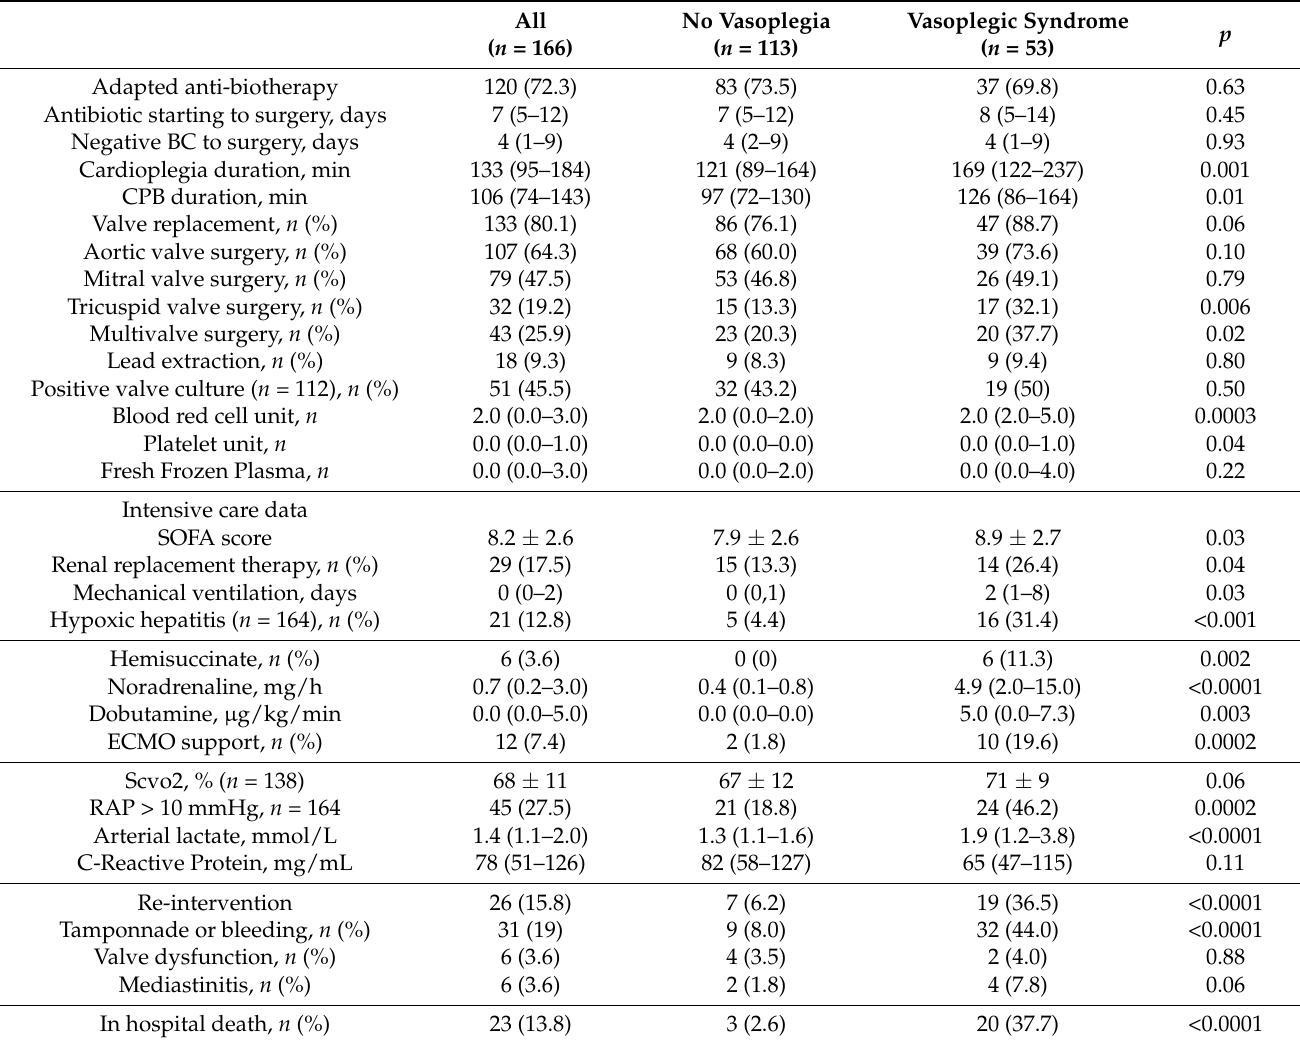
Table 3. Operative and post-operative patient’s